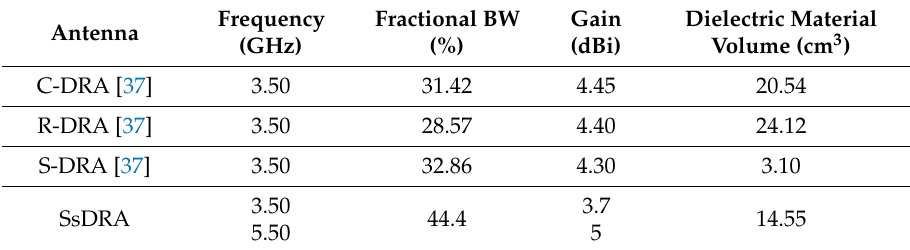
Table 2. Comparison of antenna performance and volume of material among the di ff erent DRAs, conceived by using same low-permittivity